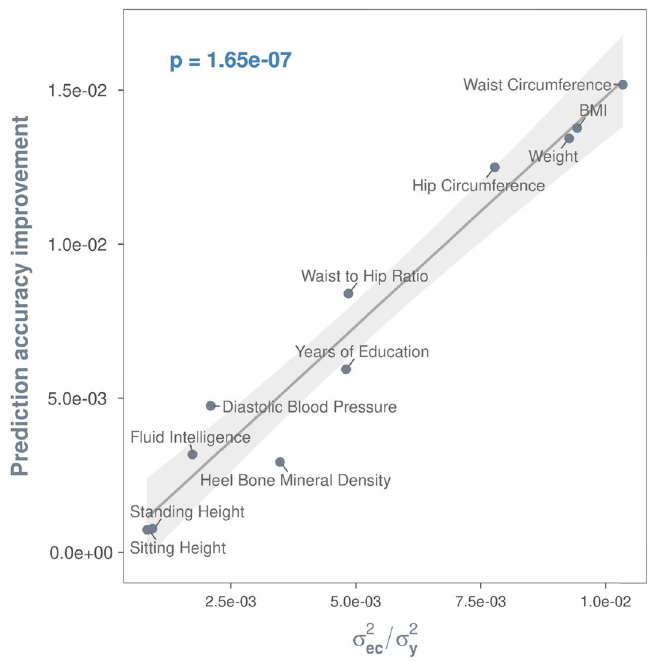
Figure 3. Positive relationship between phenotypic variance explained by exposome-by-covariate (exc) interaction effects and prediction accuracy improvement. Prediction accuracy improvement is computed by subtracting the prediction accuracy of the model y = g + e + ε from that of a model with multiple covariates (see model equation vii in Table 2) that are shown to interact with the exposome in univariate exc interaction analyses. The least squares line with 95% confidence band is based on a linear model that regressed prediction accuracy improvement on phenotypic variance explained by exc interactions. The p-value is for the t-test statistic (df = 7) under the null hypothesis that the slope of the regression line is zero. Significant covariates included for each trait can be found in Supplementary Table